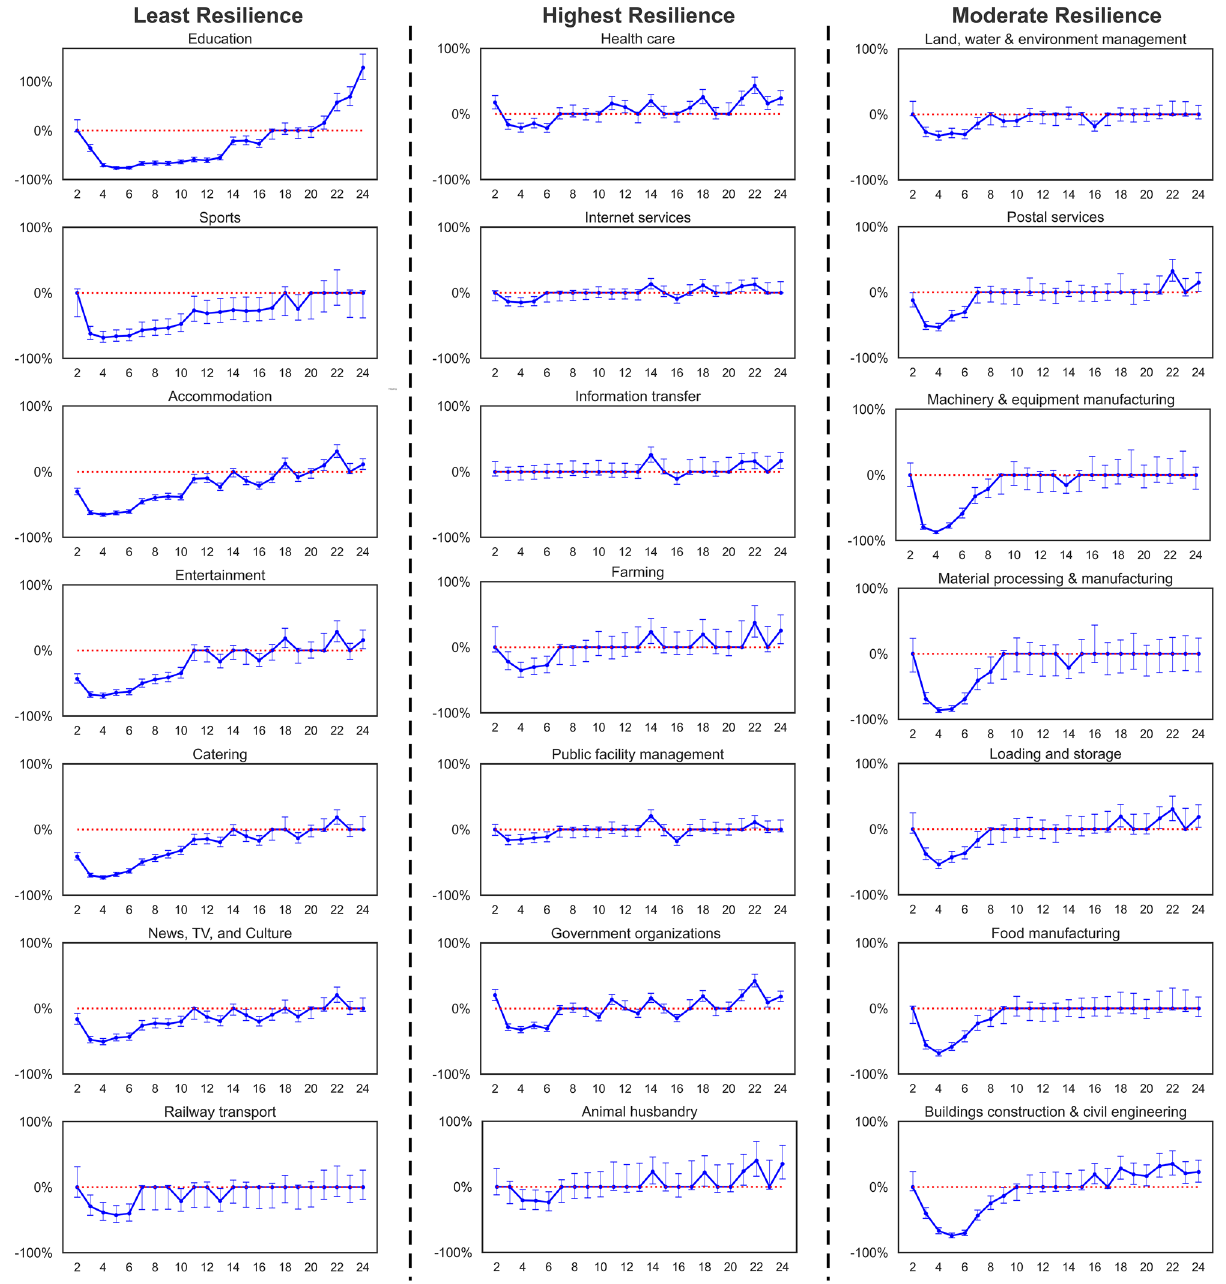
Figure 6. The dynamic causal effect of the COVID-19 outbreak on different industries. The vertical axis represents the reduction rate of electricity consumption due to the COVID-19 outbreak. The horizontal axis represents the week index, the 2nd week is the week of the Spring Festival Holiday as well as the COVID-19 outbreak. The blue line shows the dynamic causal effect of COVID-19 for the specific sub-sector from the 2nd week to the 24th week. The error bar represents the 95% confidence interval. The red dashed line is the baseline representing the situation that there is no pandemic “Manufacturing” with moderate elasticity suffered production interruptions only before the 10th week under the strictest movement control. Once workers and farmers returned to work, these industries soon returned to the pre-pandemic level of electricity consumption. The pattern of dynamic causal effects of the COVID-19 outbreak can be explained by the relevant control measures in each period. The results show that the impact of COVID-19 on the industry during and after the Spring Festival holiday presents different patterns. At first, “entertainment”, “catering”, and “accommodation” were severely affected due to the outbreak. Conversely, the outbreak resulted in fewer impacts on the secondary sector than the other two economic sectors. In China, the traditional approach is that since most employees have gone home on holiday, the secondary industry usually closes at that time. After the first week of the Spring